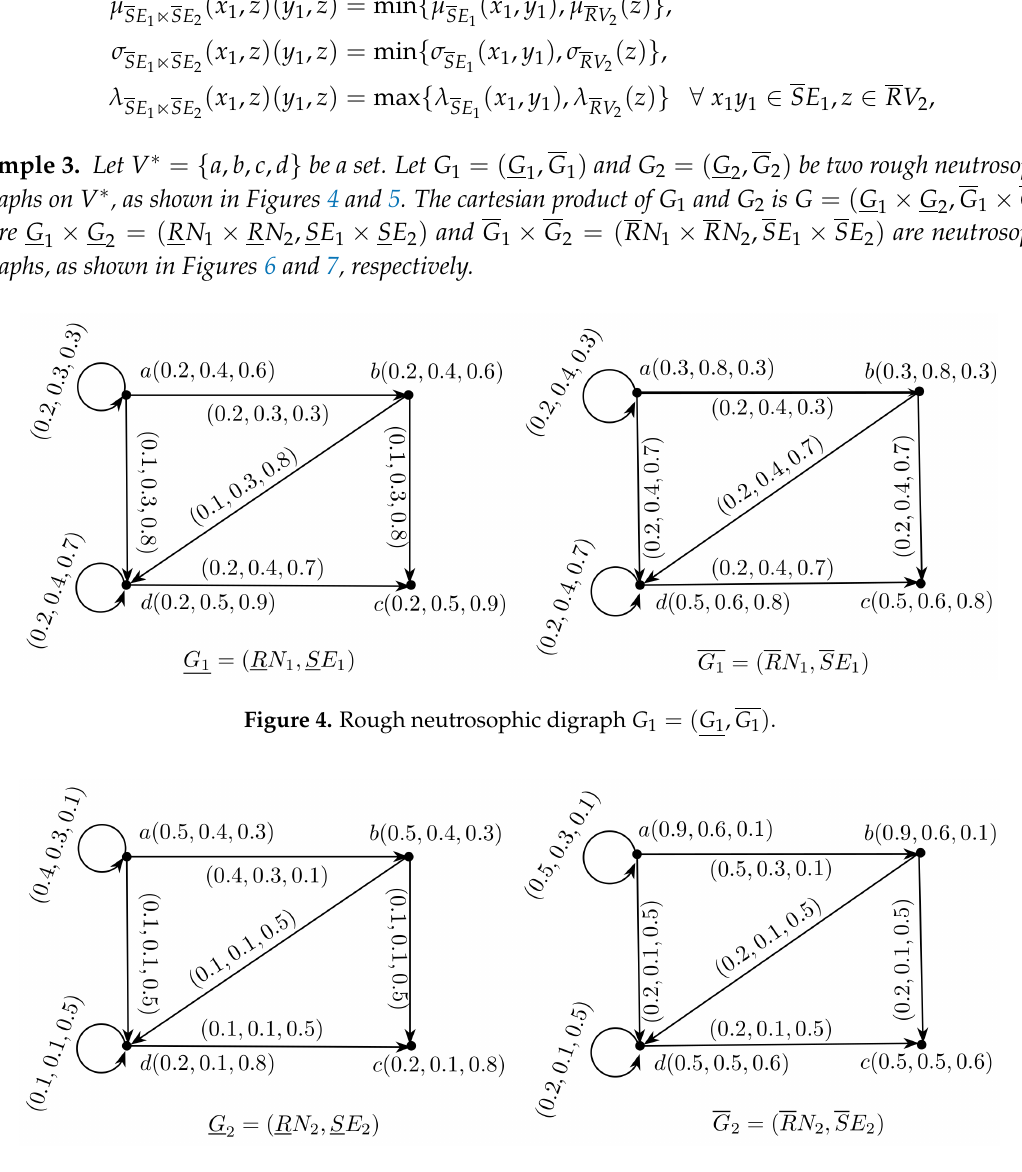
Figure 5. Rough neutrosophic digraph G 2 = ( G 2 , G 2 )